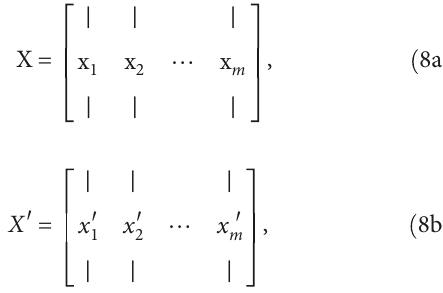
Figure 1: The left panel illustrates the nonlinear manifold on which the dynamical system de fi ned by F approximates the evolution on this manifold by a least-square fi t linear dynamical system. In contrast, the selection of appropriate observables g x de fi ne a Koopman operator that helps linearize the manifold so that a least-square fi t linear dynamical system provides a much better approximation to the system (right